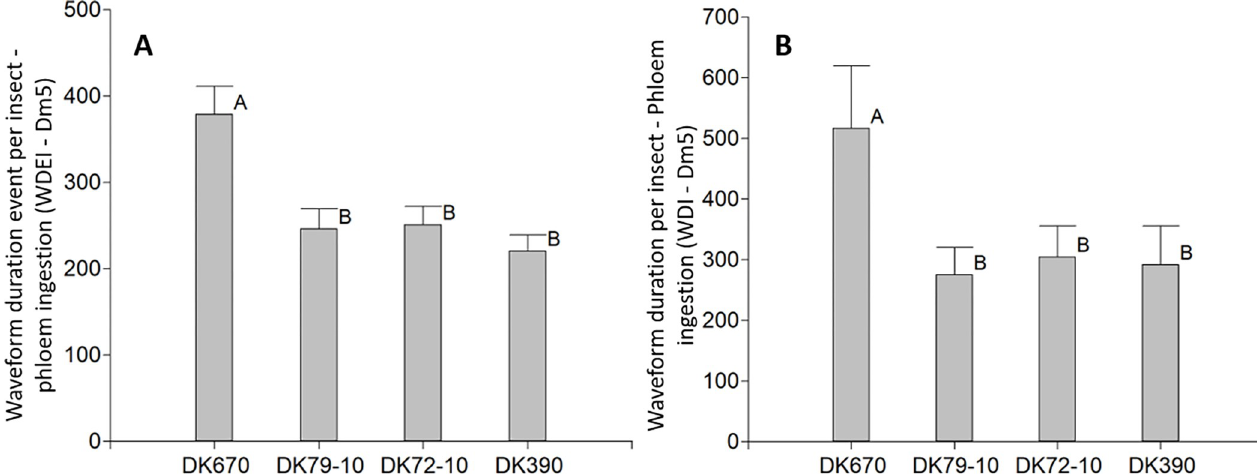
Fig 5. Variables of probing behavior by D . maidis insects with access to four maize hybrids, phloem ingestion. A: Waveform duration event per insect— Phloem ingestion (WDEI—Dm5), B: Waveform duration per insect—Phloem ingestion (WDI—Dm5). Values with the same letter are not significantly different according to contrasts in the Fisher LSD test ( α = 0.05). Bars indicate standard error of the mean.